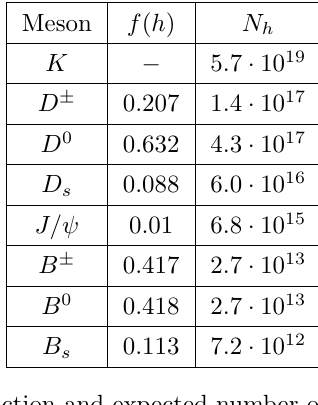
0.001 D s 5. × 10 - 4 D + D 0 2.01. × 10 - 4 0.0 0.5 1.0 1.5 Figure 21 . Branching ratio Production fraction for charm to HNL (left panel) and for beauty (cid:2) to HNL (right panel) for SHiP experiment and mixing angles U e = 1, U (cid:22) = U (cid:28) = 0. For B c meson f ( B c ) is unknown, so the result is shown for two values, f ( B c ) = 2 f ( B c ) = 2 10 (cid:0) 4 ( B c; 2 (cid:1)